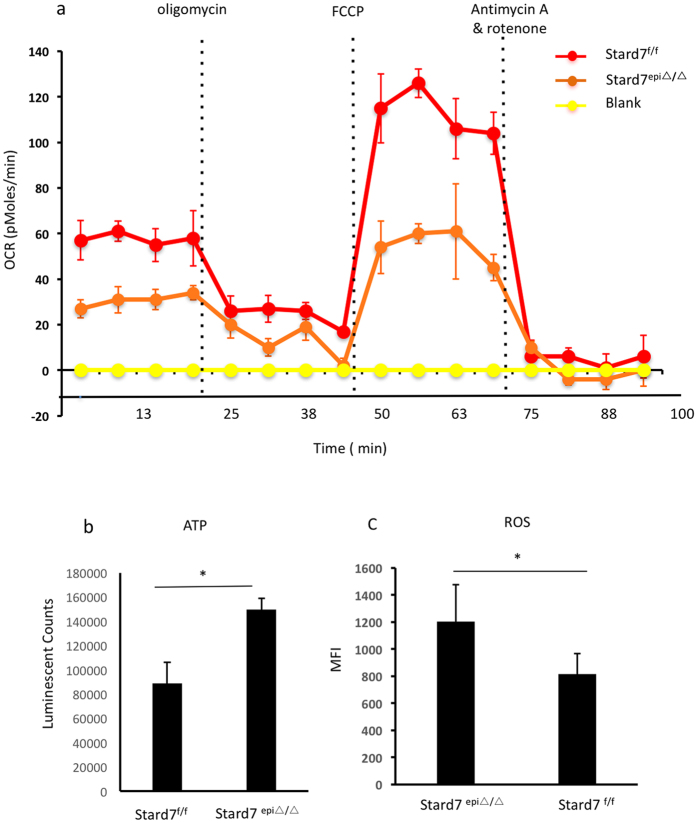
Impact of Stard7 deficiency on OCR, ATP, and ROS in lung epithelial cells.(a) Lung epithelial cells were isolated from 4-month-old Stard7f/f and Stard7epi∆/∆ mice and OCR (pMoles/min) measured under basal conditions and in response to the indicated mitochondrial inhibitors. OCR was lower in lung epithelial cells from Stard7epi∆/∆ mice (mean ± SEM, n = 5). (b) Cellular ATP levels were assessed in isolated epithelial cells. Data are presented as mean ± SEM, n = 3. There was a significant increase of ATP in lung epithelial cells of Stard7epi∆/∆ compared to Stard7f/f mice, *p = 0.0115. (c) Isolated lung epithelial cells were incubated with or without DCFDA and analyzed by flow cytometry. ROS levels were significantly increased in lung epithelial cells of Stard7epi/∆∆ mice compared to Stard7f/f mice, *p = 0.0193. Data is presented as MFI (mean ± SEM, n = 3).